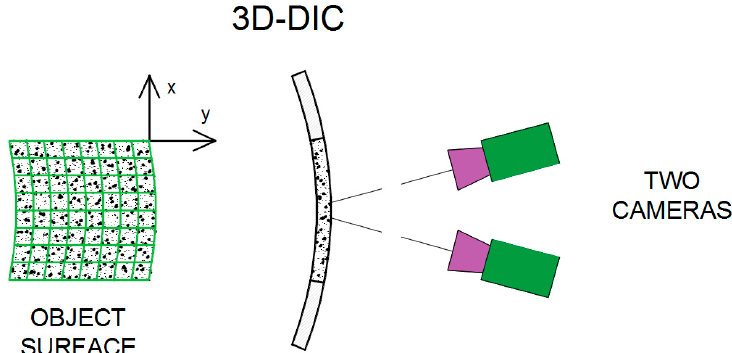
Figure 6. 3D-Digital Image Correlation system [17,18,20]. (The Creative Commons Attribution (CC BY 4.0) license (http: // creativecommons.org / licenses / by / 4.0 /